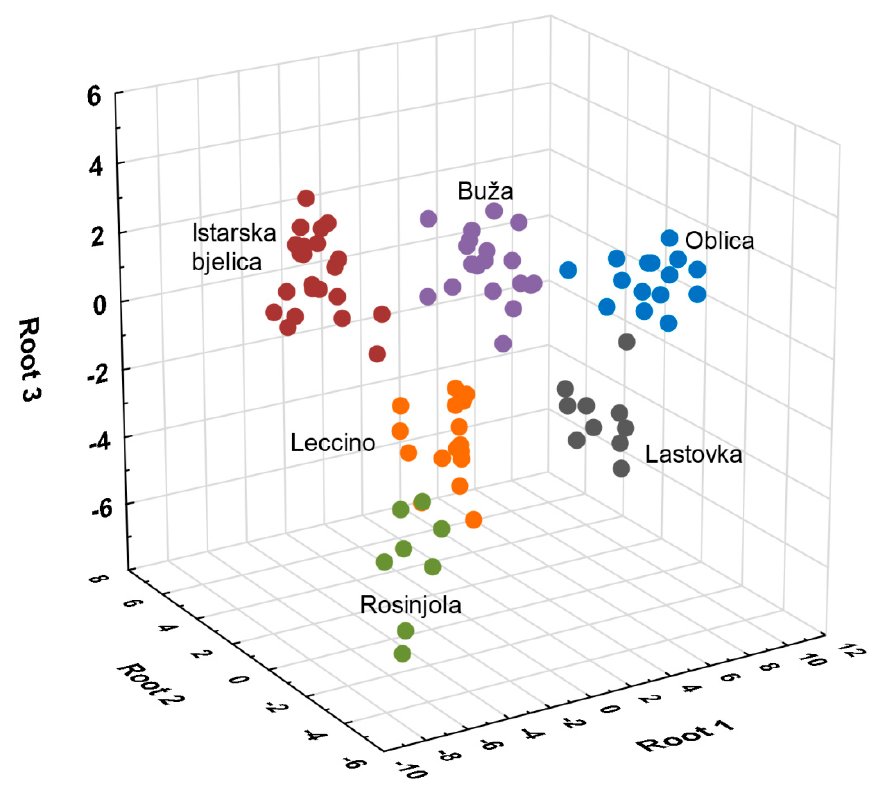
Figure 1. Separation of monovarietal extra virgin olive oils produced from Buža, Istarska bjelica, Rosinjola, Oblica, Lastovka, and Leccino varieties in Croatia according to variety in three-dimensional space defined by the first three discriminant functions (roots) on the basis of volatile aroma compound composition.